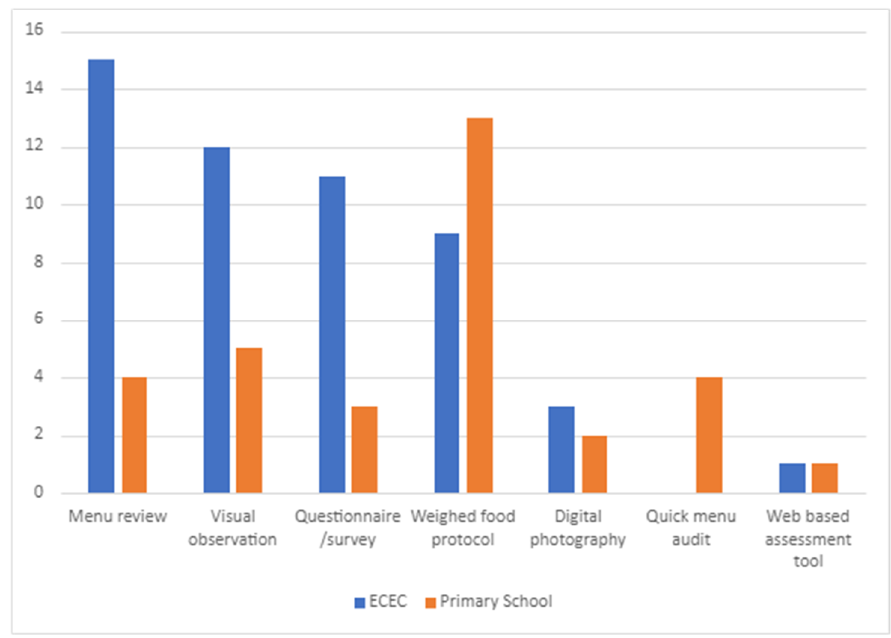
Figure 2. Identified measurement methods for food provision in ECEC and Primary School settings.